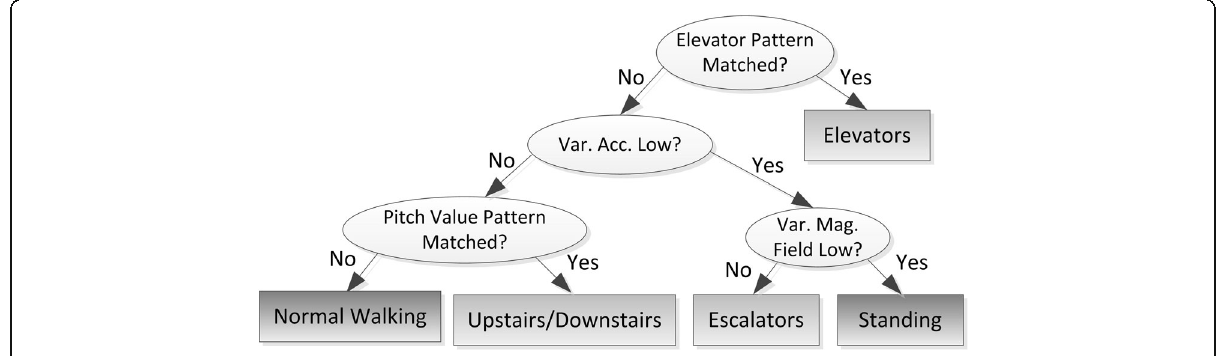
Fig. 2 Identification of landmarks using a decision